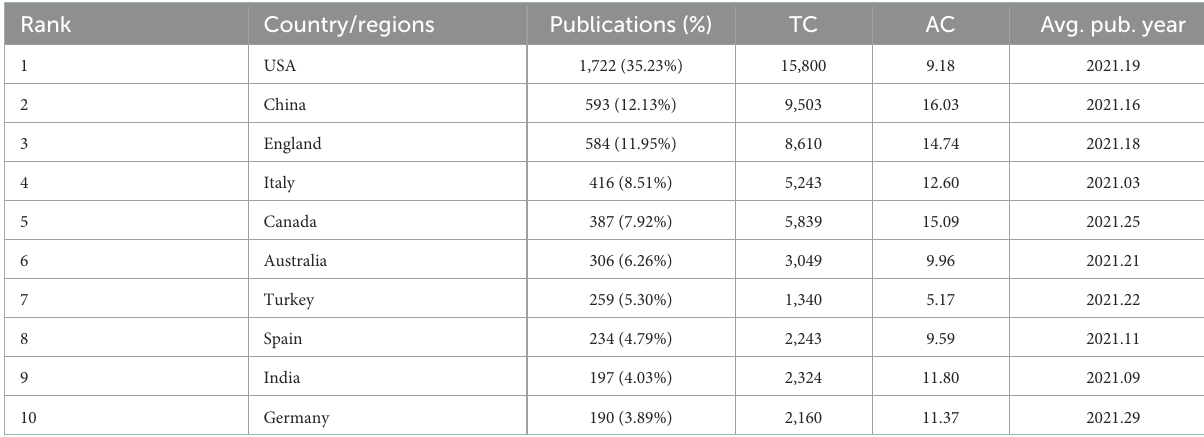
TABLE 1 Top 10 countries/regions according to publications.